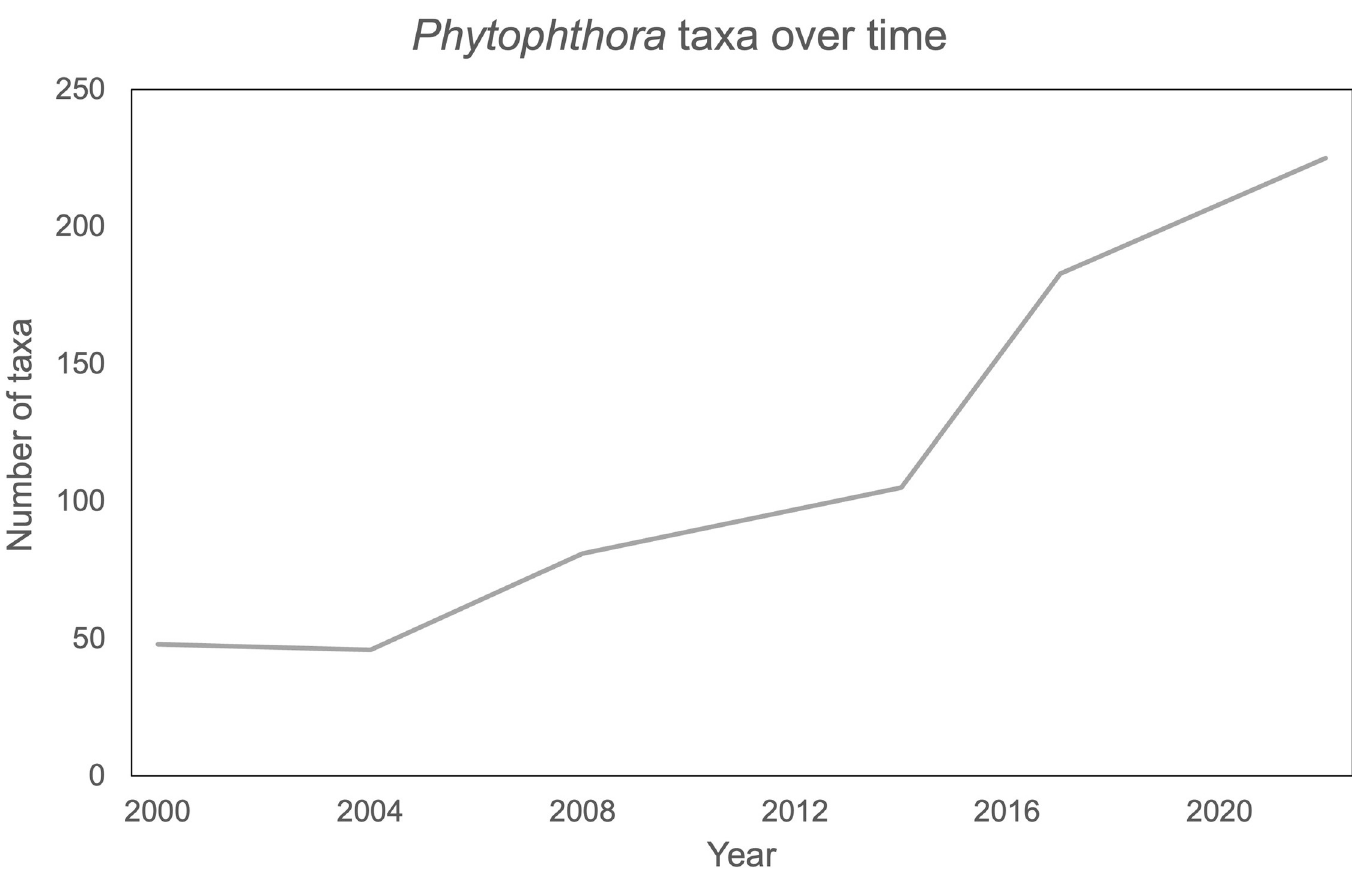
Fig 1. Number of species in the Phytophthora genus. Line graph showing the number of Phytophthora species included in different phylogenies from 2000 to the current study.